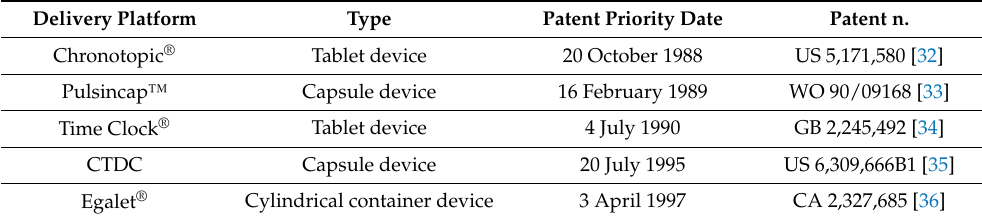
Table 1. Patents of time-controlled delivery platforms proposed for colonic release, for which proof- of-concept was achieved by human γ -scintigraphy studies.